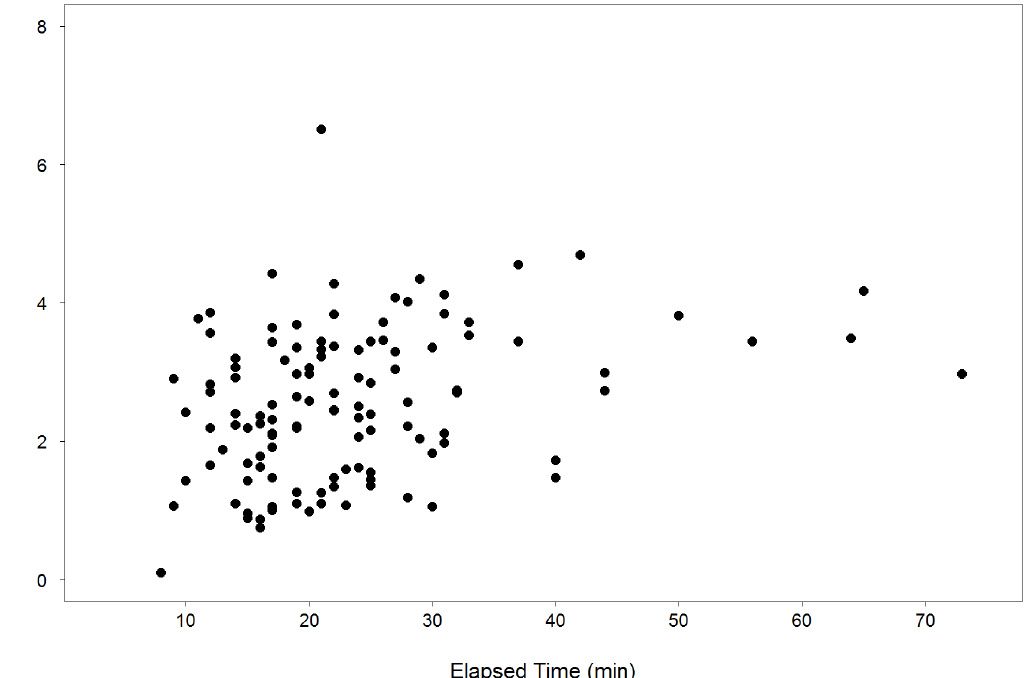
Fig 1. Pre-Sampling Cortisol versus Elapsed Sampling Time. Pre-sampling cortisol concentration ( μ g/dL) vs. elapsed sampling time (min) for bottlenose dolphins sampled in Sarasota Bay, FL 2000 – 2012 (N = 118)